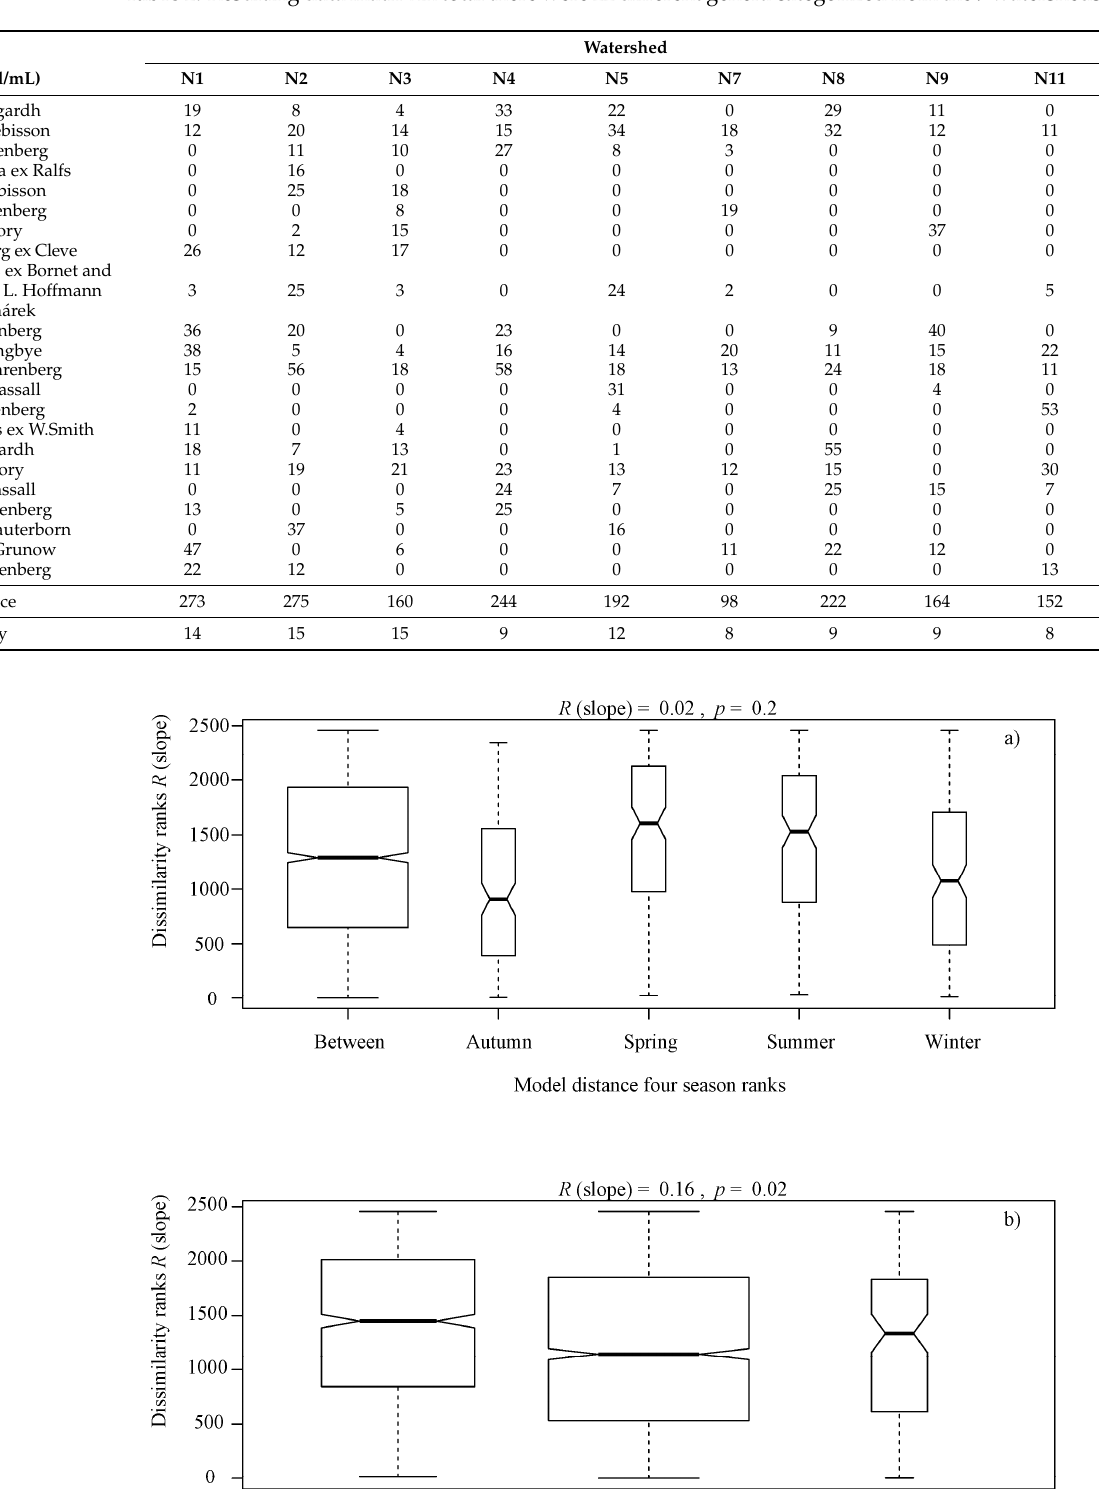
Table 2. Resulting data matrix in total there were 22 different genera categorized from the 9 watersheds.